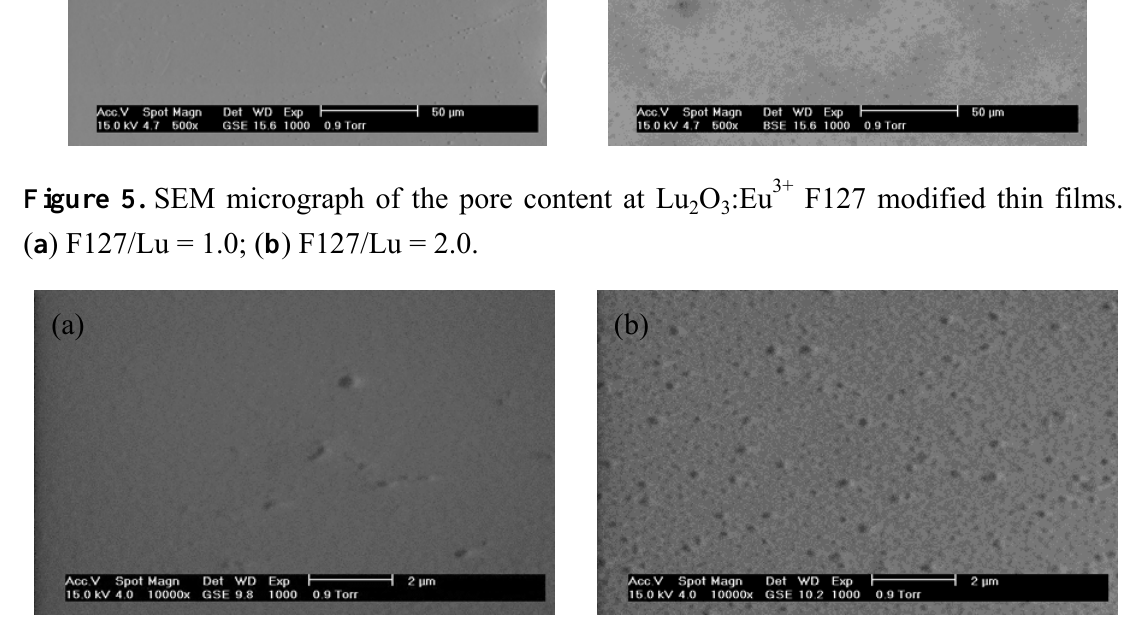
Figure 4. Scanning electron microscope (SEM) micrograph of Lu